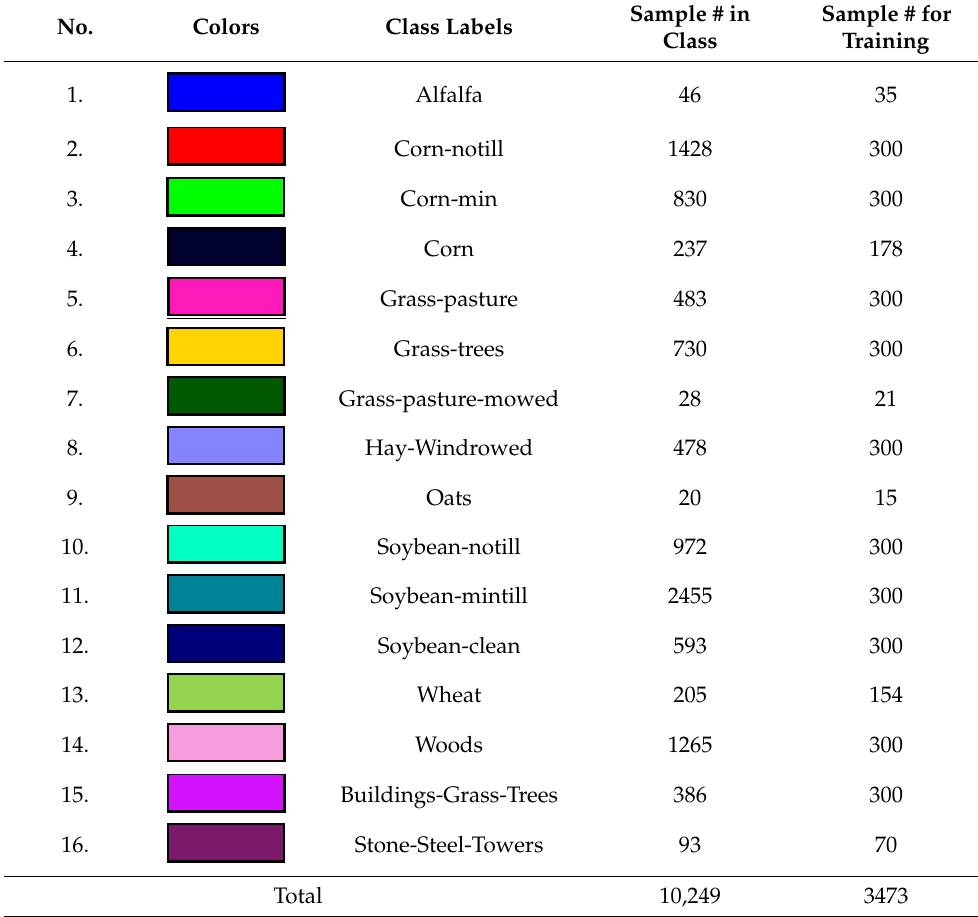
Figure 4. The analysis for the training data in dataset Salinas: ( a ) The overlapping degrees of various values α , ( b ) The visualized training sample distribution of PCA and 𝑟 = 0.41 , ( c ) The visualized training sample distribution of value 𝛼 = 0 and 𝑟 = 0.34 , ( d ) The visualized training sample distribution of value 𝛼 = 0.95 and 𝑟 = 0.18 , and ( e ) The visualized training sample distribution of value 𝛼 = 1 and 𝑟 = 0.07 .